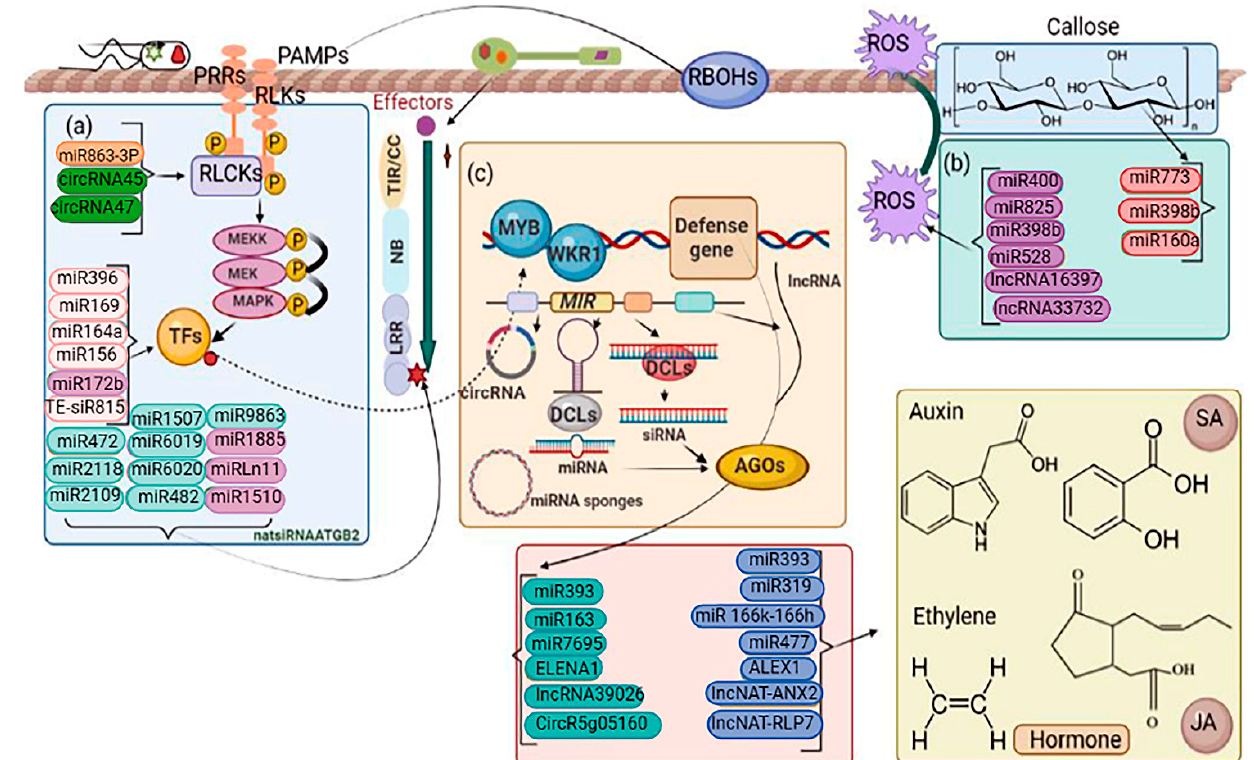
Figure 6. Interfering ncRNAs in plant immunity. Membrane PRRs and cytoplasmic NLRs are essential receptors of the plant immune response. Membrane PRRs mainly contain receptor-like kinases (RLKs) and receptor-like proteins (RLPs). Both are commonly involved in PTI. NLRs are another type of plant safety receptor commonly involved in ETI. Pattern recognition receptors (PRRs) and NLRs are regulated at transcriptional, post-transcriptional, and post-translational levels. Downstream signaling components of these receptors include kinases, transcription factors, etc. A variety of proteins and several plant ncRNAs directly target the expression of signaling components to regulate reaction immunity. ( a ) Noncoding RNAs (ncRNAs) regulate immune signaling components. PRRs and NLRs, such as FLS2 and RPS5, are immunological receptors that mediate pathogen recognition. RLCKs and TFs implicated in immunological signal transduction, such as SpRLK and WRKY45, are regulated by other ncRNAs. ( b ) ncRNAs that affect plant immunity by modulating numerous biological processes such as ROS accumulation, callose deposition, defense-related gene expression, and plant hormone regulation, either directly or indirectly. ( c ) In immunity, ncRNAs play a coordinated role. PhasiRNAs can be triggered by miRNAs that target NLR genes. Target mimics and miRNA/siRNA precursors are the major functions of lncRNAs. CircRNAs may operate as miRNA decoys, increasing the production of miRNA-targeted mRNAs. PAMPs, pathogen-asso- ciated molecular patterns; PRRs, pattern recognition receptors; RLKs, receptor-like kinases; RLCKs, receptor-like cytosolic kinases; TFs, transcription factors; P, phosphorylation; ROS, reactive oxygen species; DCL, DICER-LIKE; AGO, ARGONAUTE; SGS3, SUPPRESSOR OF GENE SILENCING 3; and RDR6, RNA-dependent RNA polymerase 6. Dark purple ovals are involved in ROS accumula- tion, including miR400 , miR825 , miR3985 , miR528 , IncRNA16397, and IncRNA33732. Dark pink ovals are involved in callose deposition, including miR773 , miR398b , and miR160a . Blue ovals, in- cluding miR393 , miR319 , miR166k - 166h , miR477 , ALEX1, IncNATANX2, and IncNAT-RLP1, are in- volved in regulating hormones. Turquoise blue ovals, including miR393 , miR163 , miR7695 , ELENA1, and circRg05610, are involved in PATHOGENESIS-RELATED ( PR ) gene expressions. Light pink,